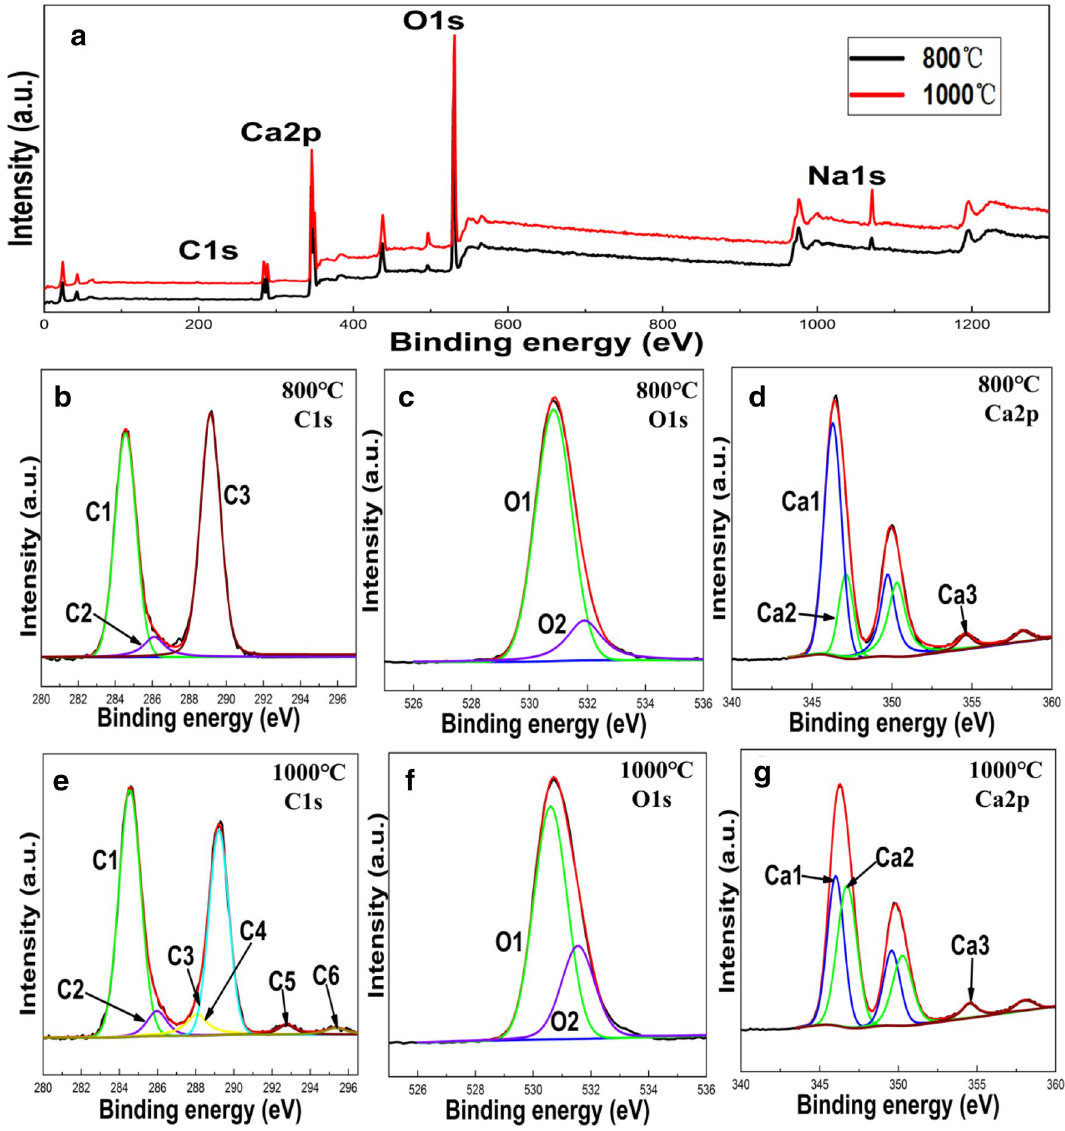
Figure 3. ( a ) XPS survey scan of CSCs at 800 °C and 1000 °C; XPS spectra of clam shell samples at: 800 °C ( b ) Ca2p, ( c ) C1s, ( d ) O1s, and 1000 °C ( e ) Ca2p, ( f ) C1s, ( g ) O1s of